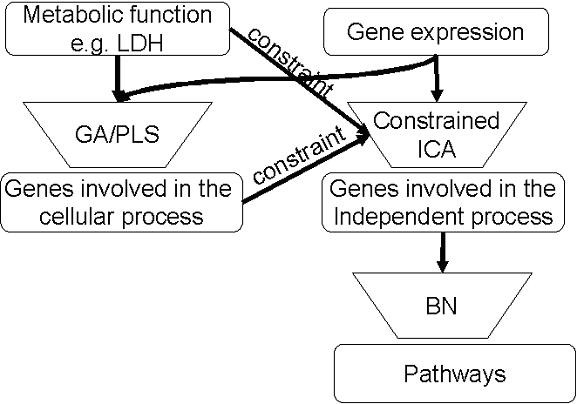
The framework to integrate gene expression and metabolic profiles. The relevancy of each gene to LDH release was first evaluated with GA/PLS. Genes with higher frequencies were considered to be more relevant. The frequencies and profile of the LDH release were then used to constrain the ICA model to extract an independent component that represents the cellular process. The genes in the independent component with high coefficients were subjected to BN analysis.